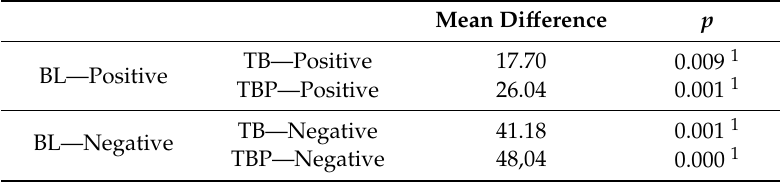
Table 3. p -Values for Wilcoxon tests for purposefulness of activation